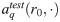
Dynamics of the color neural field Eq (3).The neural activities are plotted after a. one, b. two, c. thirty iterations, and convergence is reached after fifteen iterations. The red curve indicates the activity aqtest(r0,·) of hypercolumn r0 corresponding to the test stripe. Other blue curves correspond to spatial points ri located on surrounding stripes. Notice that only four and not eight different curves are seen, because of the axial symmetry artificially introduced to facilitate numerical computations, as explained in S2 Appendix. A video of the dynamics is provided in
S1 Video.